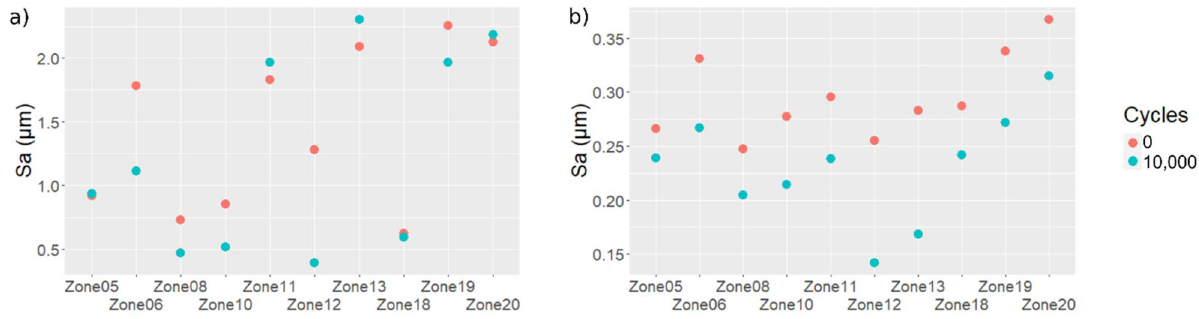
Figure 5. Arithmetic mean deviation (Sa) computed for the 10 selected measurements showing the largest wear traces ( a ) without filtering, ( b ) with filtering (high-pass filter with a 25 µm cut-off